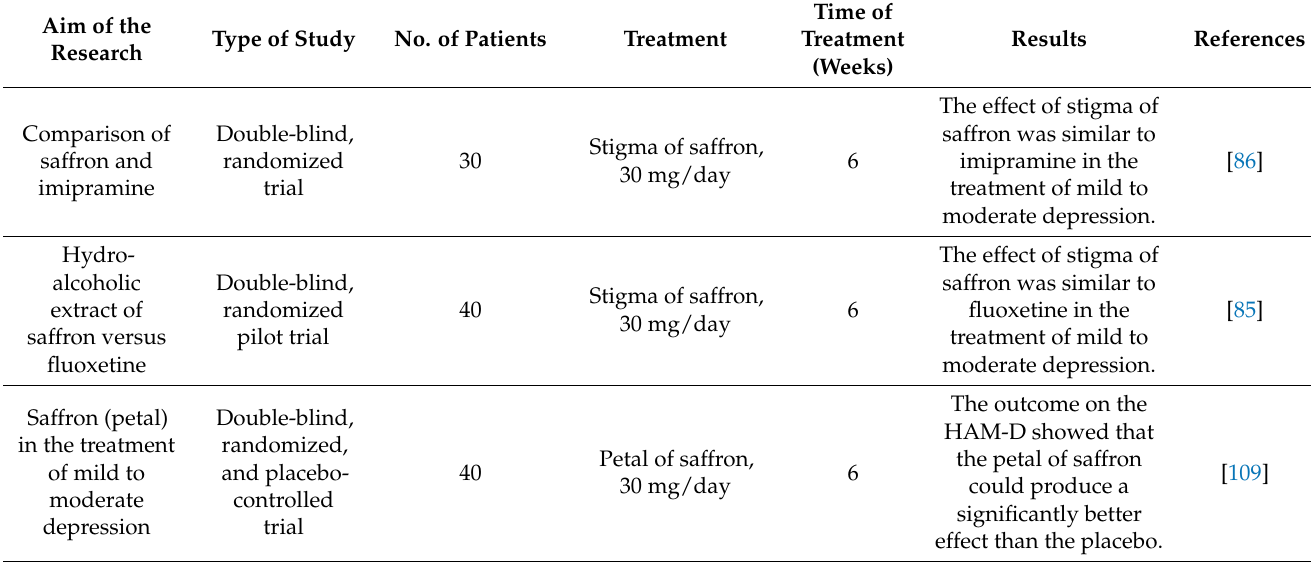
Table 3. Studies on pharmacological activities relating to anti-depressant-like effects of saffron. BDI, Beck depression inventory; HAE, hydro-alcoholic extract; PCI, percutaneous coronary intervention; CAD, coronary artery disease; HAM-D, Hamilton Depression Rating Scale; PMS: premenstrual syndrome; GAD, generalized anxiety disorder; MMT, methadone maintenance